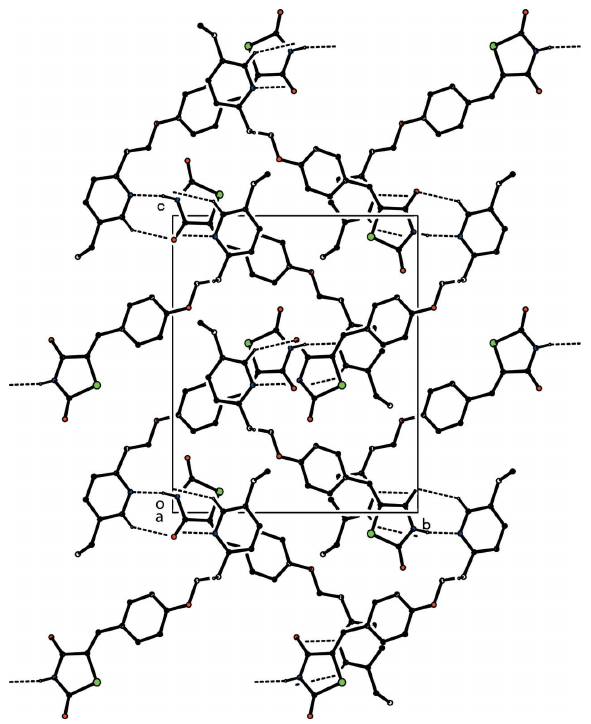
Figure 2 The crystal packing viewed along the a axis. Hydrogen bonds are shown as dashed lines. H atoms not involved in hydrogen bonding have been omitted for clarity.